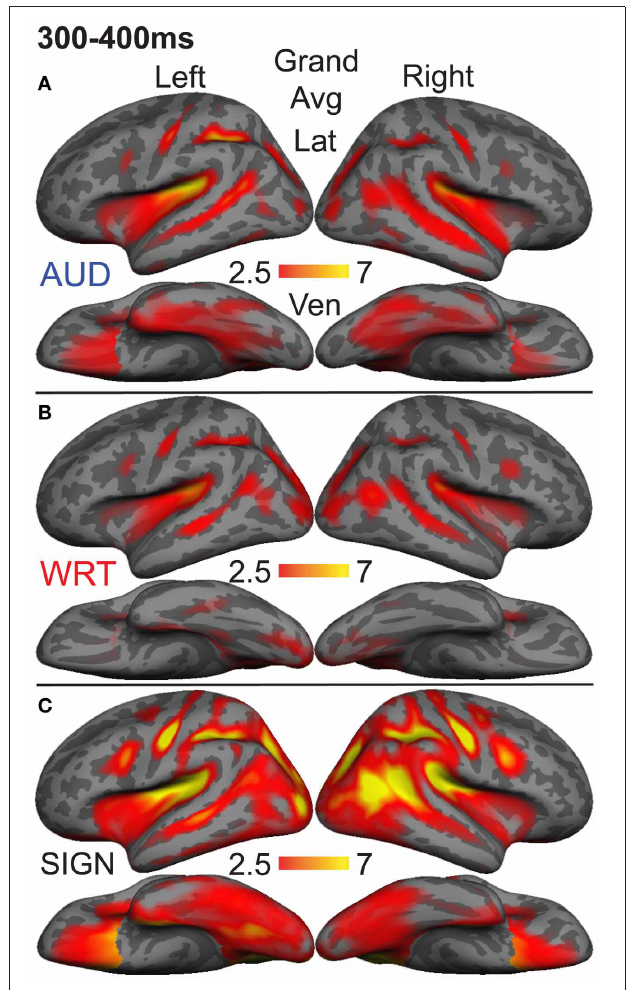
FIGURE 8 | Grand average group dSPMs during the late lexico-semantic time window from 300 to 400ms. (A–C) All three conditions show a similar pattern of activity in bilateral regions. (C) Signed words (“SIGN”) show much stronger activity, particularly in the right hemisphere. F -values on the color bars represent signal-to-noise